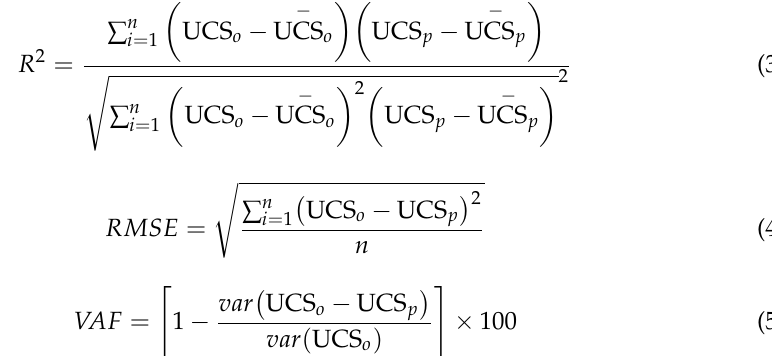
Figure 9. ANN model M1 results for UCS plotted against the measured data.